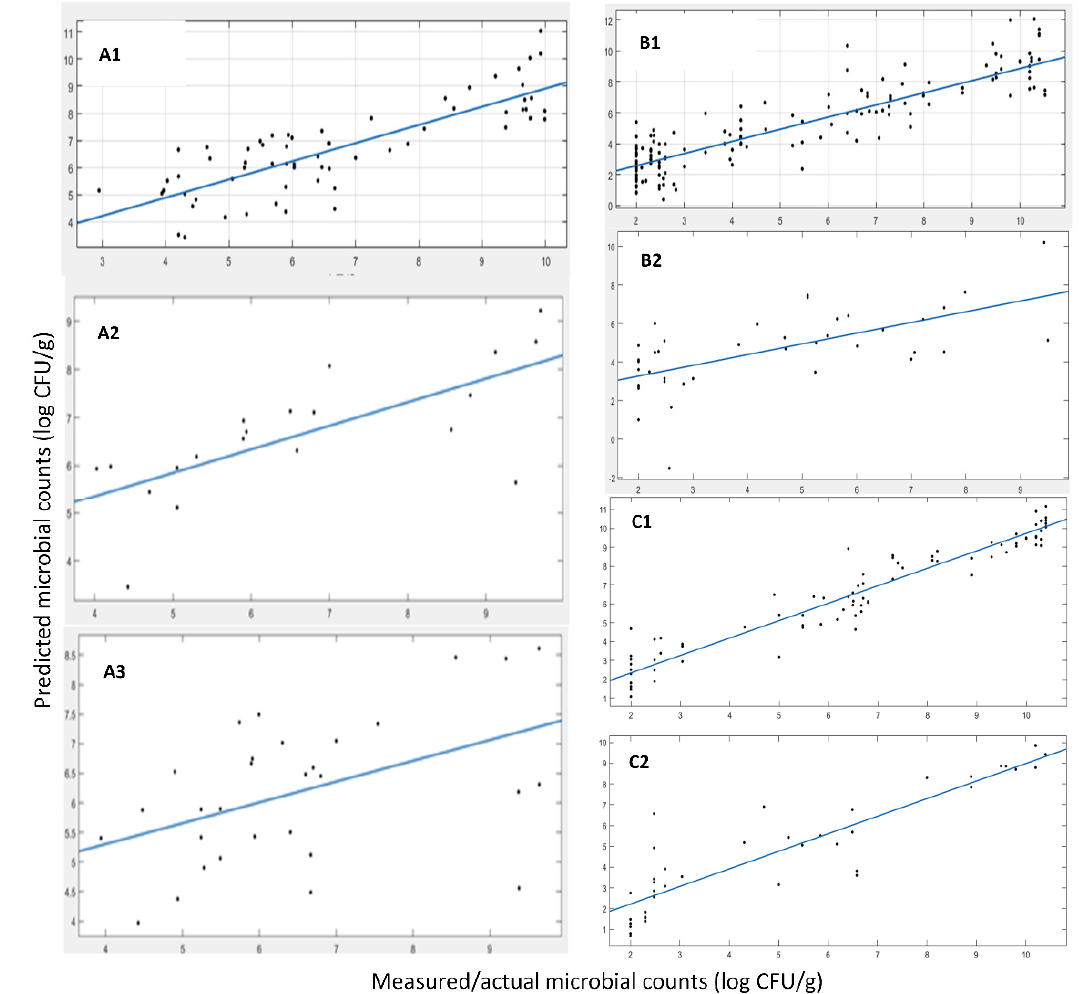
Figure 7. Linear regression between the predicted and the measured microbial counts using MSI data. ( A1 ) cross validation MI samples, ( A2 ) test/external validation from harvest 2019 and 2020 MI samples, ( A3 ) test/external validation from harvest 2019, 2020 and 2021 MI samples, ( B1 ) cross validation SAMS samples, ( B2 ) test/external validation SAMS samples, ( C1 ) cross validation, ( C2 ) test/external validation MI+SAMS